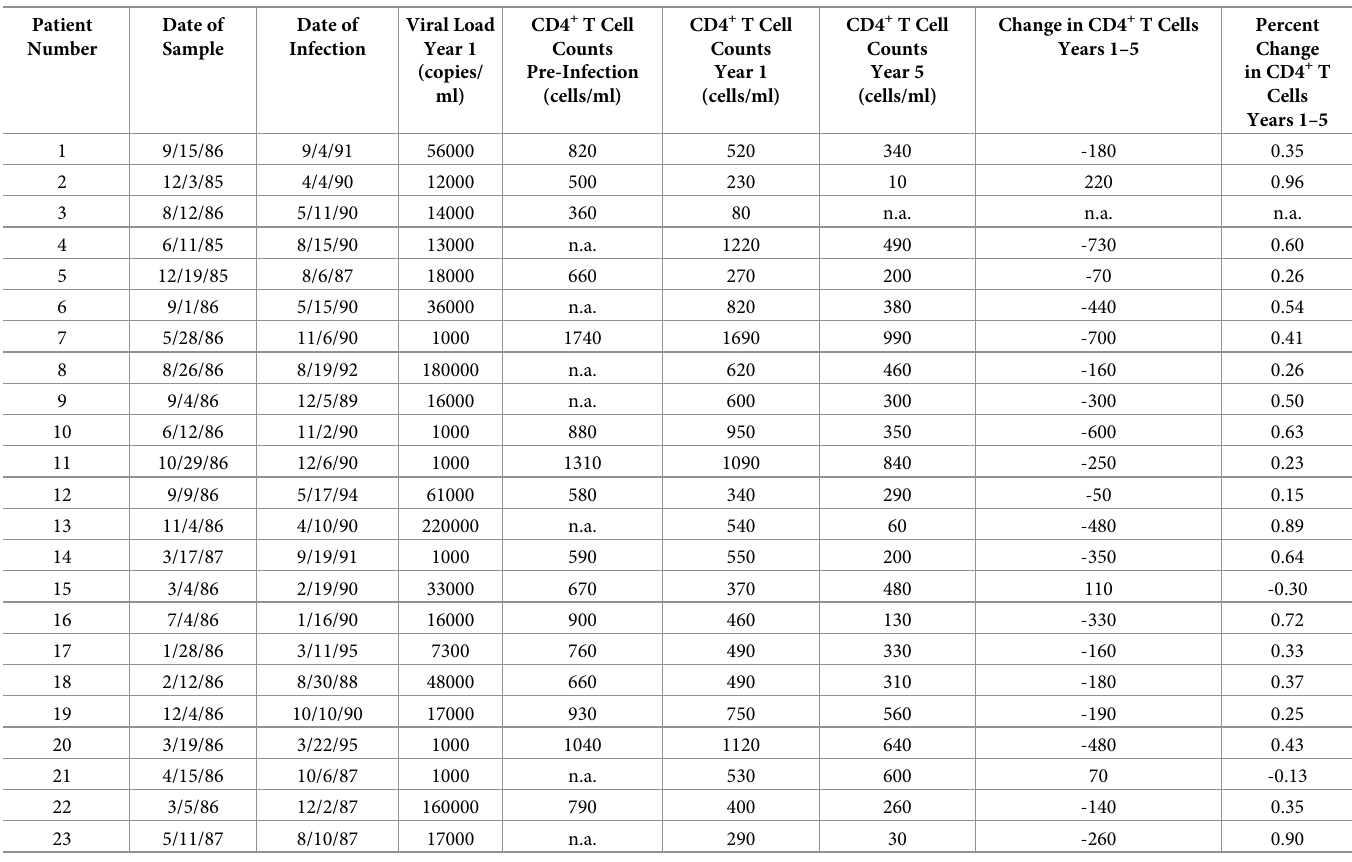
Table 2. Characteristics of HIV-infected subjects from the Amsterdam Cohort studies. Patient